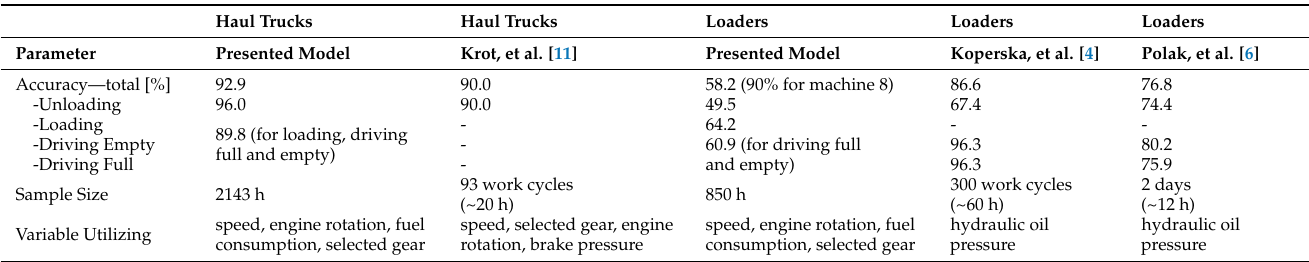
Table 6. Comparative analysis of results between models presented in this article and other models in literature which accuracy is